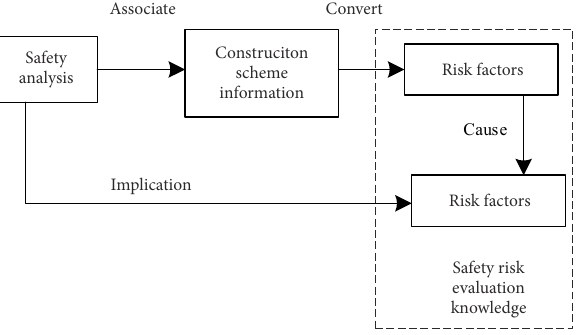
factorsRisk Cause knowledgeRisk Safety risk evaluation